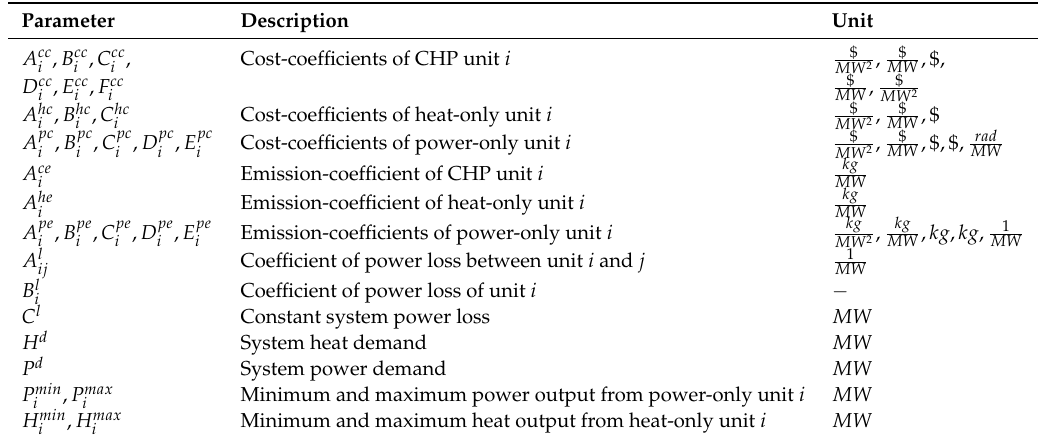
Table 2. Parameters used for modeling CHP dispatch.